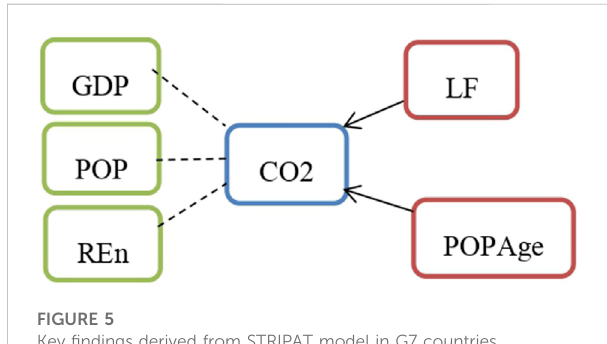
FIGURE 5 Key fi ndings derived from STRIPAT model in G7